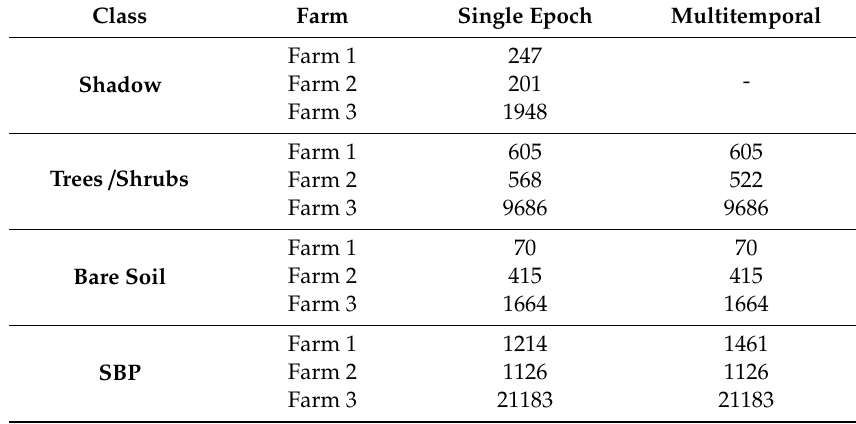
Table A8. Number of points used for accuracy assessment for each class in single epoch and multitemporal classification. SBP – Sown Biodiverse